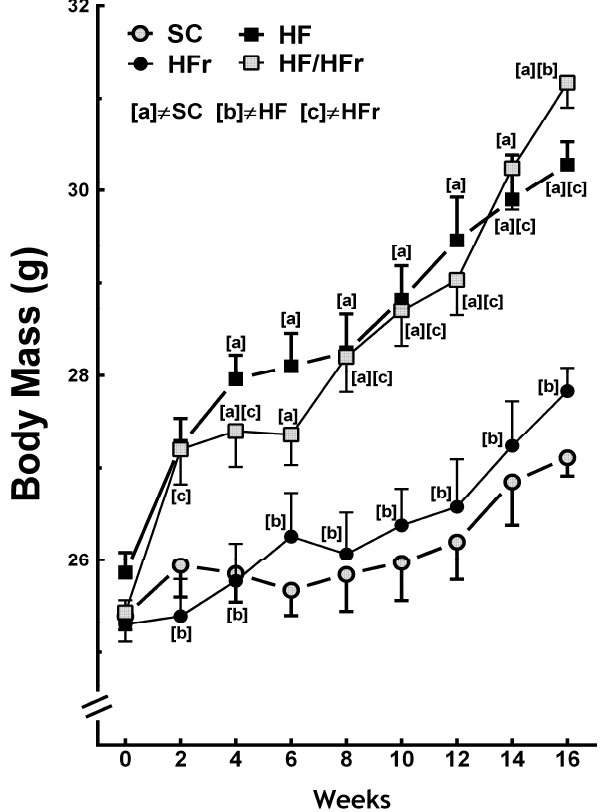
Figure 1. Body mass. Diets were administered for 16 weeks. SC (standard chow group), HF (high-fat group), HFr (high-fructose group), HF/HFr (high-fat and high-fructose group). Values are means ± standard error. There was a significant difference ( p ≤ 0.05 for the same week) compared with the a SC group; b HF group; and c HFr